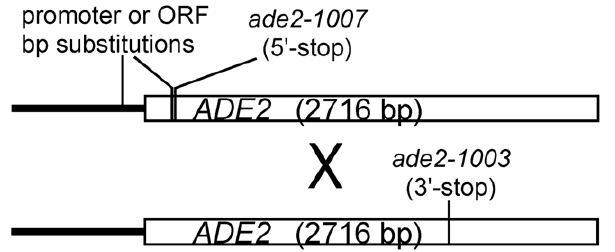
Figure 1. Schematic representation of the ADE2 coding region (open rectangles) and promoter (thick black line) and the positions of sequence substitutions tested in this study. Crosses were performed with the indicated allele, ade2-1003 (3 9 -stop) to determine recombination frequencies of sequence motifs created in the promoter or 5 9 -region of the ORF.